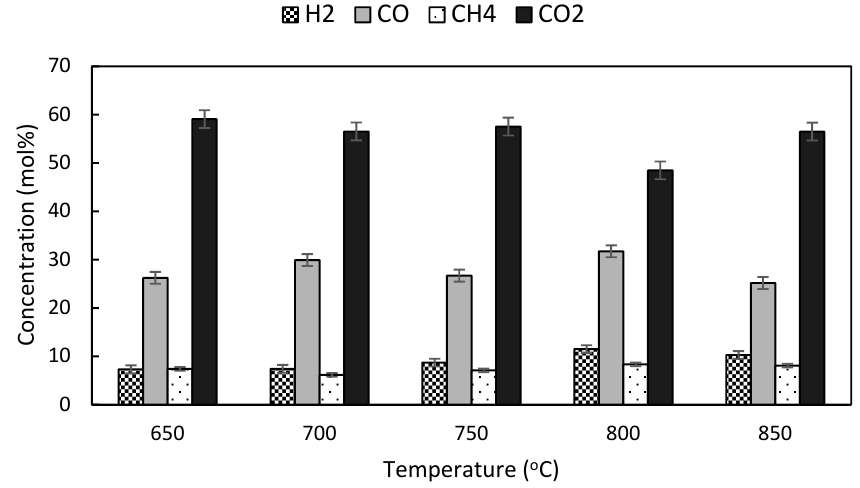
Figure 6. E ff ects of temperature on gas composition at ER of Figure 6. Effects of temperature on gas composition at ER of 0.25.